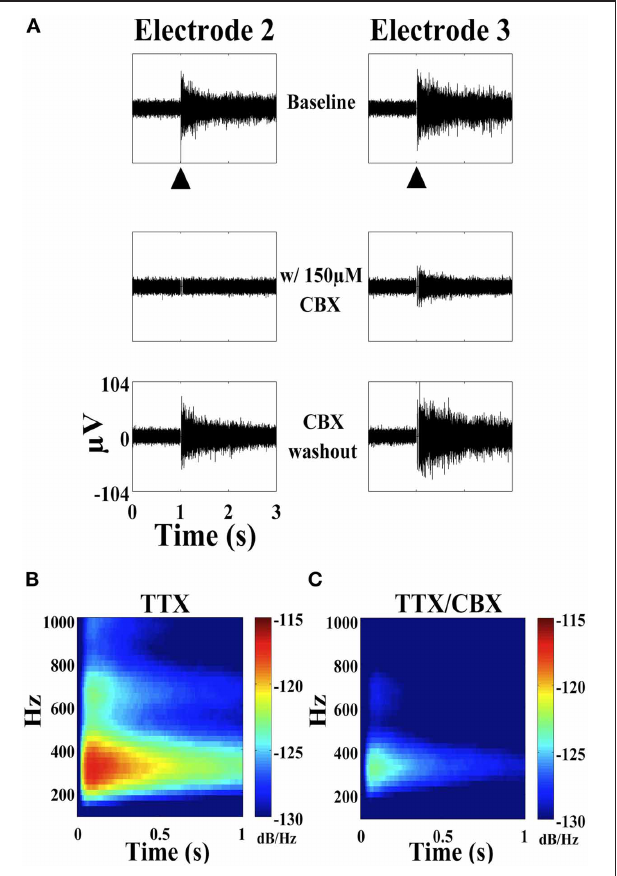
FIGURE 8 | Effect of EGTA on the stimulus-evoked oscillation. (A) Sixty seconds of representative SALPA filtered traces at baseline, with 10mM EGTA and after washout (five days). 0.5V stimulus (large black arrowhead). (B) Average power spectra showing baseline with TTX 1 μ M and (C)